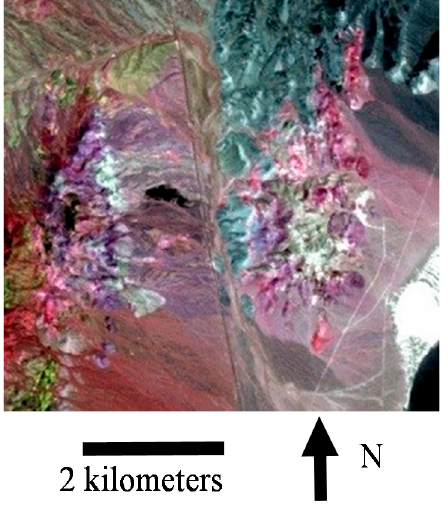
Figure 5. The AVIRIS Cuprite sub-scene.